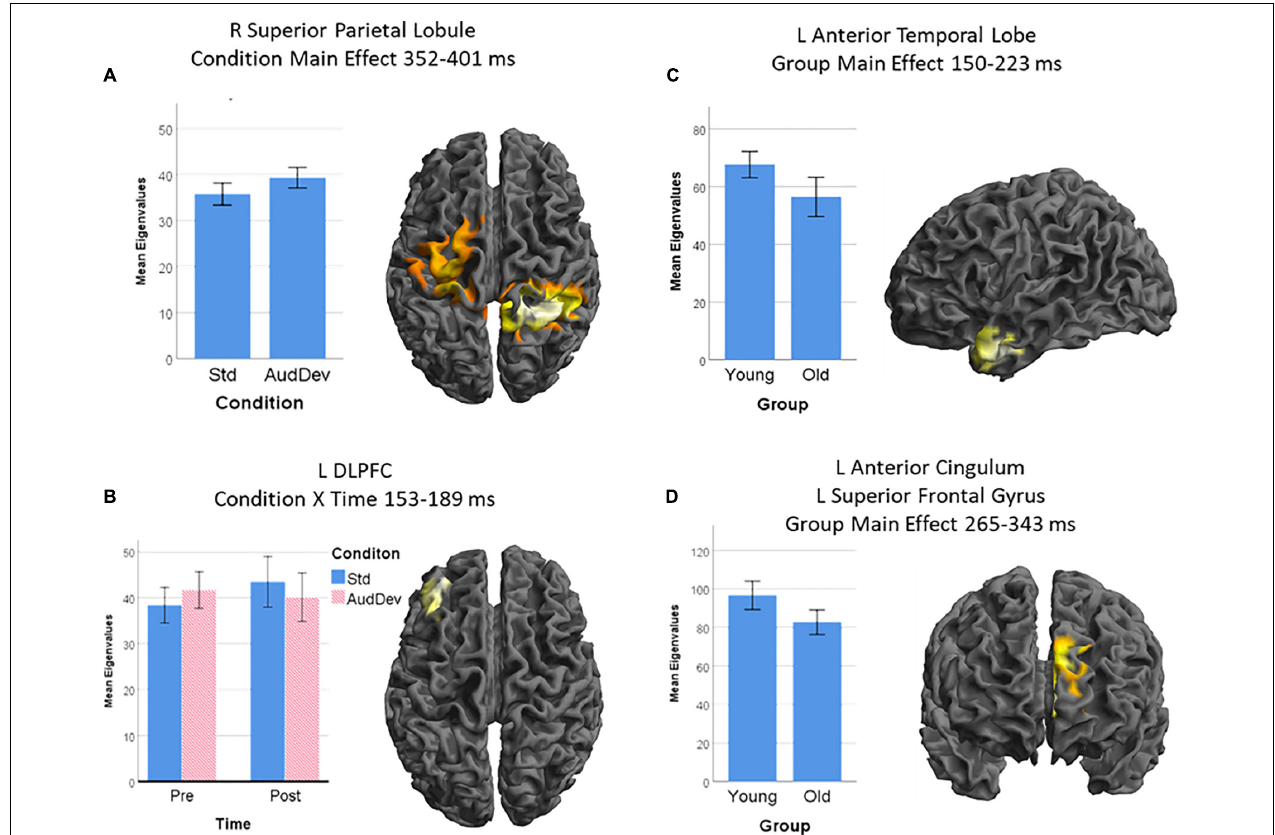
FIGURE 4 | Source-level results of the statistical analysis of the LORETA images. Only the Auditory strand of analysis yielded source-level results, with four clusters: (A) a cluster over the right superior parietal lobule and the left pre- and post-central gyrus, being more activated in the Auditory deviant condition than the Standard condition; (B) a cluster over the left dorsolateral prefrontal cortex (DLPFC), being more activated after training but only in the Standard condition (condition × time interaction); (C) a cluster over the anterior part of the left temporal lobe, being more active in younger adults than older adults; and (D) a cluster over the left superior frontal gyrus extending medially to the left anterior cingulum, being more activated in younger adults than older adults. Cluster-extent thresholds corrected by GRF; cluster-forming threshold p = 0.01. Graphs show post hoc analysis of extracted eigenvalues. Error bars show 95% CI.